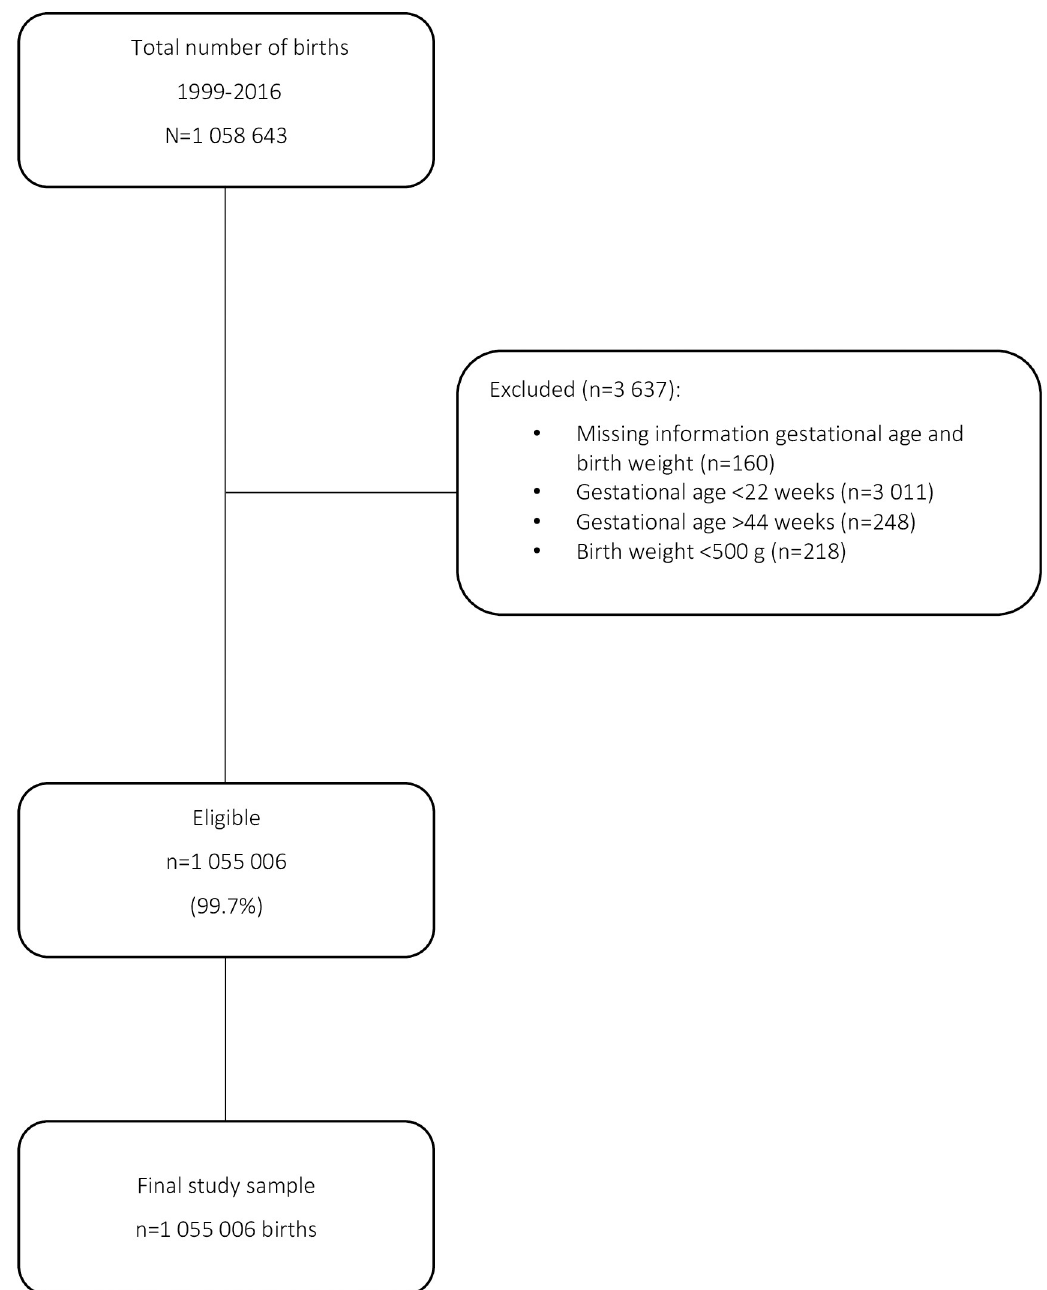
Fig 1. Selection of study